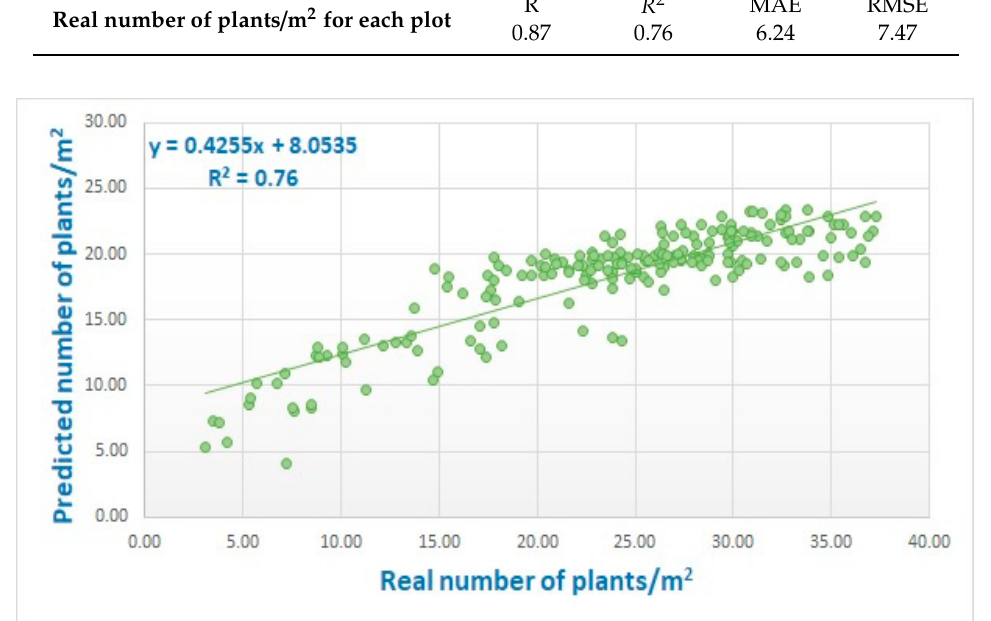
Table 5. Statistical parameters for comparison of real and predicted number of plants/m 2 for each plot in model calibration. R—correlation coefficient, R 2 —coefficient of determination, MAE—mean absolute error, and RMSE—root mean squared error. Model Validation in 2019 Predicted Number of Plants/m 2 for Each Plot Real number of plants/m 2 for each plot